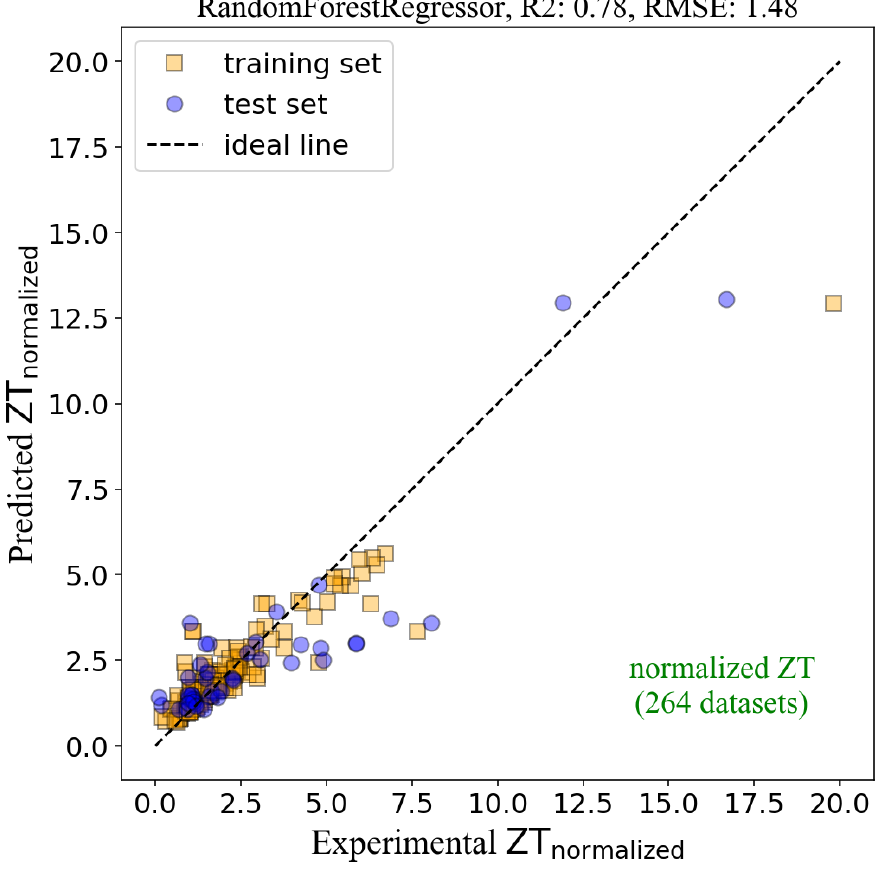
Figure 3. The plot of the Predicted ZT normalized versus the Experimental ZT normalized from the ML model using RF regressor. The total datasets of 264 datasets were used, resulting in the R 2 of 0.78 and the RMSE of 1.48.